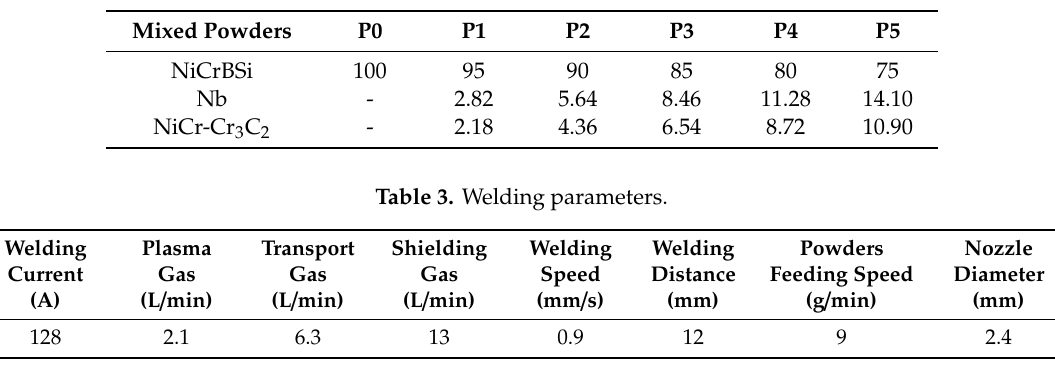
Table 2. The compositions of the powders used in this research (wt.%).